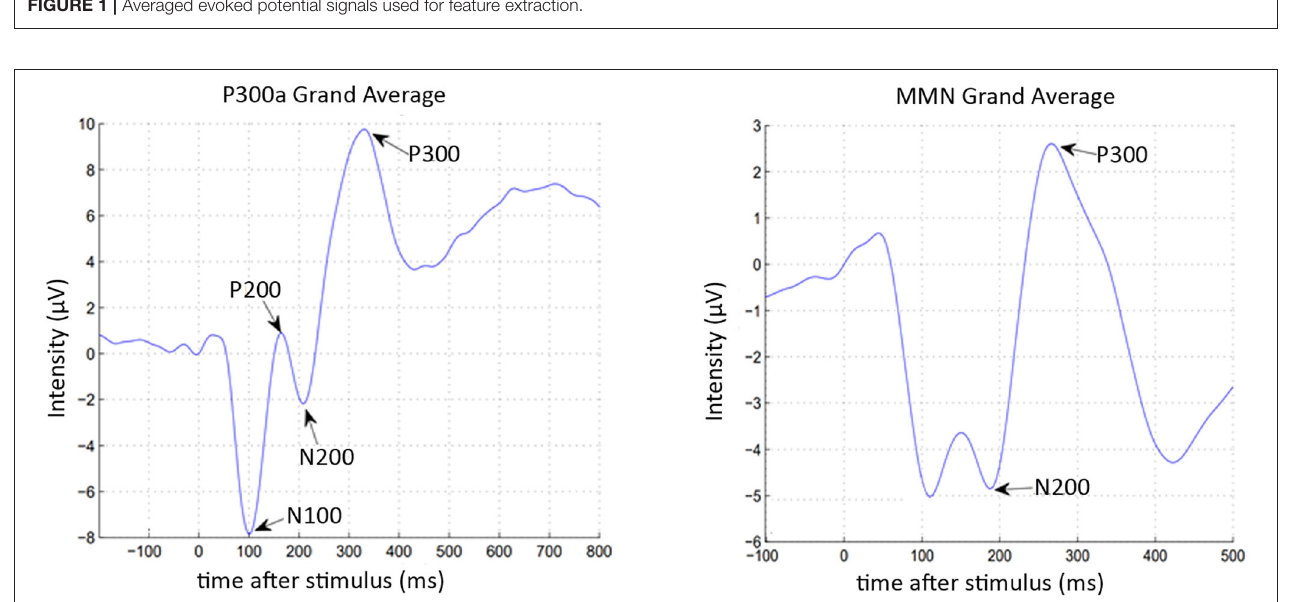
FIGURE 1 | Averaged evoked potential signals used for feature